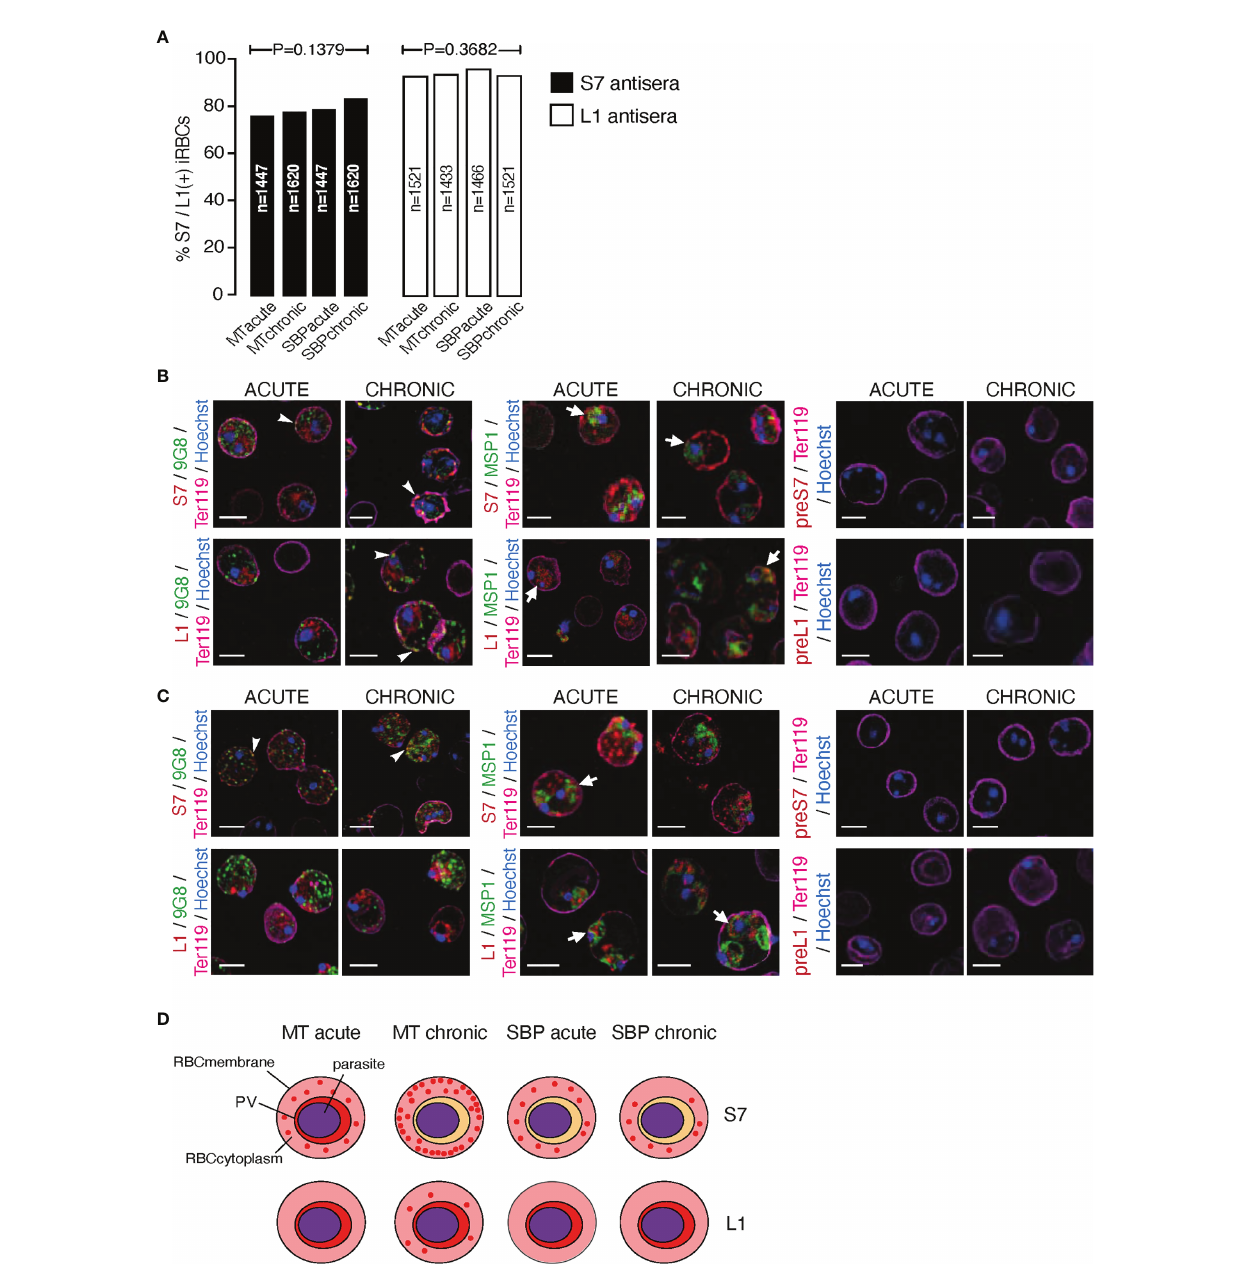
FIGURE 2 | Subcellular localisation of S7 and L1 PIRs in the late trophozoite-stage of MT and SBP P. c. chabaudi AS parasites, during the acute- and chronic- phases of infection. (A) Percentage of MT and SBP S7-positive (dark grey) and L1-positive (light grey) parasitised erythrocytes, at the late trophozoite-stage. N represents the total number of iRBC analysed in three biological replicates. Data are presented as mean with SEM. Statistical signi fi cance was calculated using one- way Analysis Of Variance (ANOVA) tests (P < 0.05). (B, C) Immuno fl uorescence assays of MT (B) and SBP (C) WT P. chabaudi parasites at the late trophozoite- stage. Blood was isolated from C57Bl/6 RAG1 -/- mice. Parasites were primarily stained with the anti-S7 or anti-L1 peptide sera (red), and later with the anti-clone 6 (9G8) or anti-MSP1 monoclonal antibodies (green). The white arrowheads indicate co-localisation of the S7s or L1s with 9G8, whereas the white arrows indicate co- localisation of the S7s and L1s with MSP1. Erythrocyte membrane was stained with the rat anti-Ter119 monoclonal antibody (magenta), and parasite nuclei were stained with Hoechst (blue). Staining with pre-immune sera was used as negative control (right panel). Images were taken from confocal sections of acetone: methanol fi xed parasites at X630 magni fi cation. Scale bar length corresponds to 5 m m. (D) Schematic representation summarising the results obtained following confocal imaging of MT and SBP P. chabaudi parasites. The localisation pattern of S7s and L1s across the acute- and chronic-phases of infection in MT and SBP parasites is indicated in red. RBCmembrane, Red Blood Cell Membrane; PV, Parasitophorous